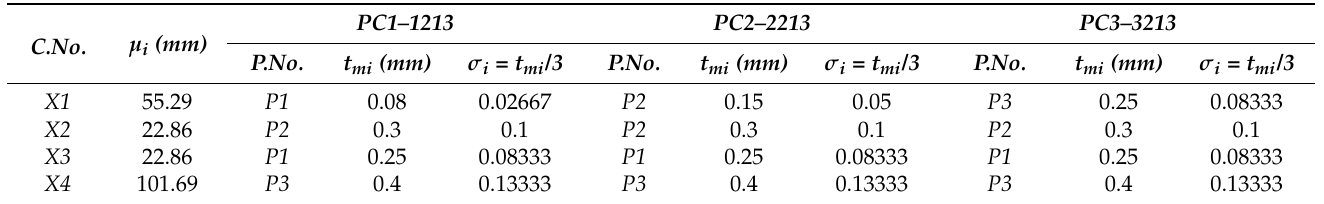
Table 3. Mean and standard deviation of components for different process combinations.